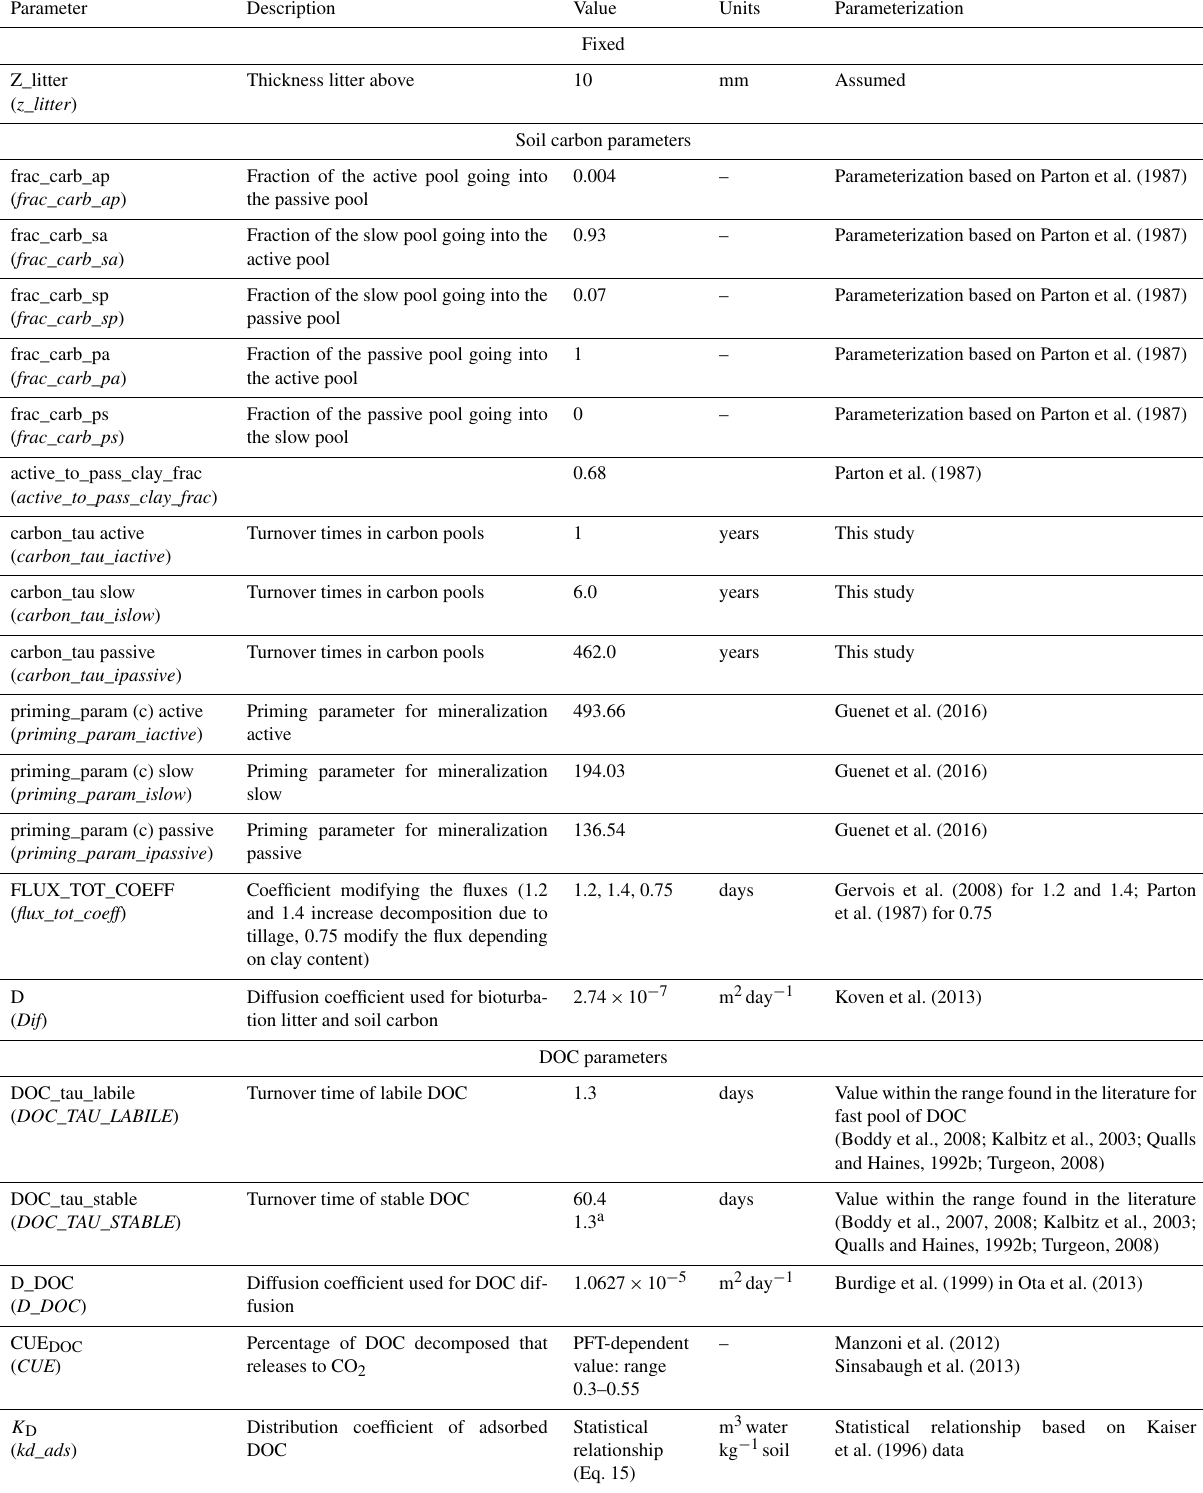
Table 1. List of parameters of ORCHIDEE-SOM (the name used in the model is between brackets), with their description, value, units, and the parameterization used for each